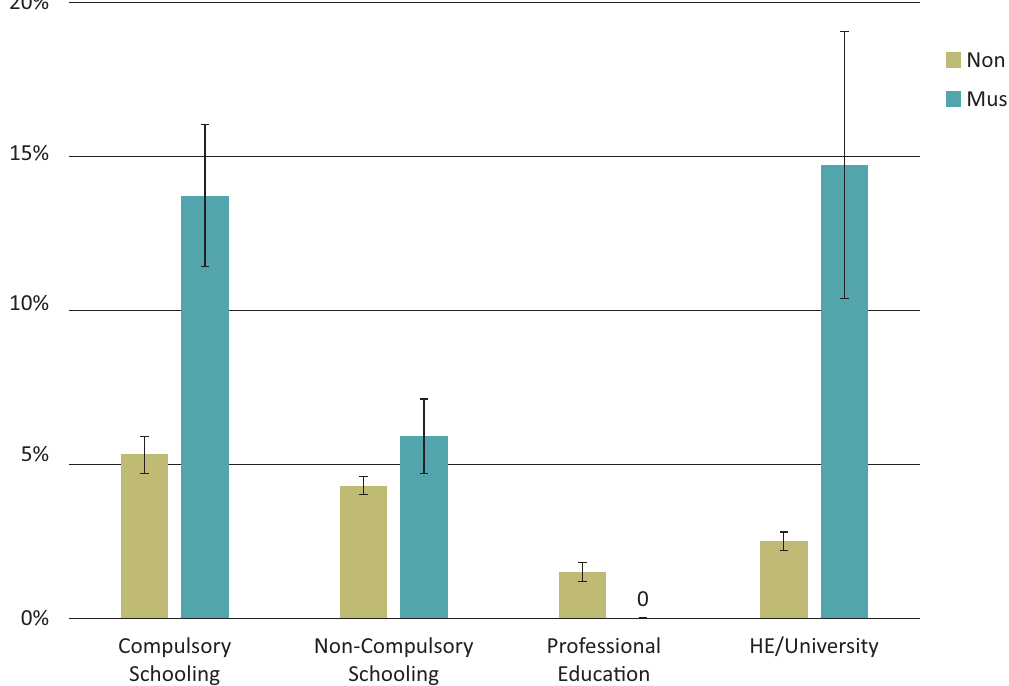
Figure 1. Probability of being unemployed for Muslims compared to non-Muslims for different levels of education. 2 According to intersectional approaches, one cannot use analytical categories such as gender, race, and class independently, in the sense that they produce overlapping structures of inequalities (Browne & Misra, 2003). The same can be said about religious affiliation and ethnicity: they work as “‘simultaneous and linked’ social identities” (Wilde & Glassman, 2016), and it is not always possible to distinguish discrimination mechanisms based on one or the